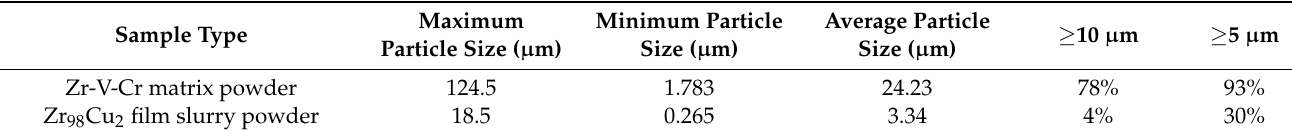
Table 5. Particle size parameters of Zr-V-Cr matrix powder and Zr 98 Cu 2 slurry powder.